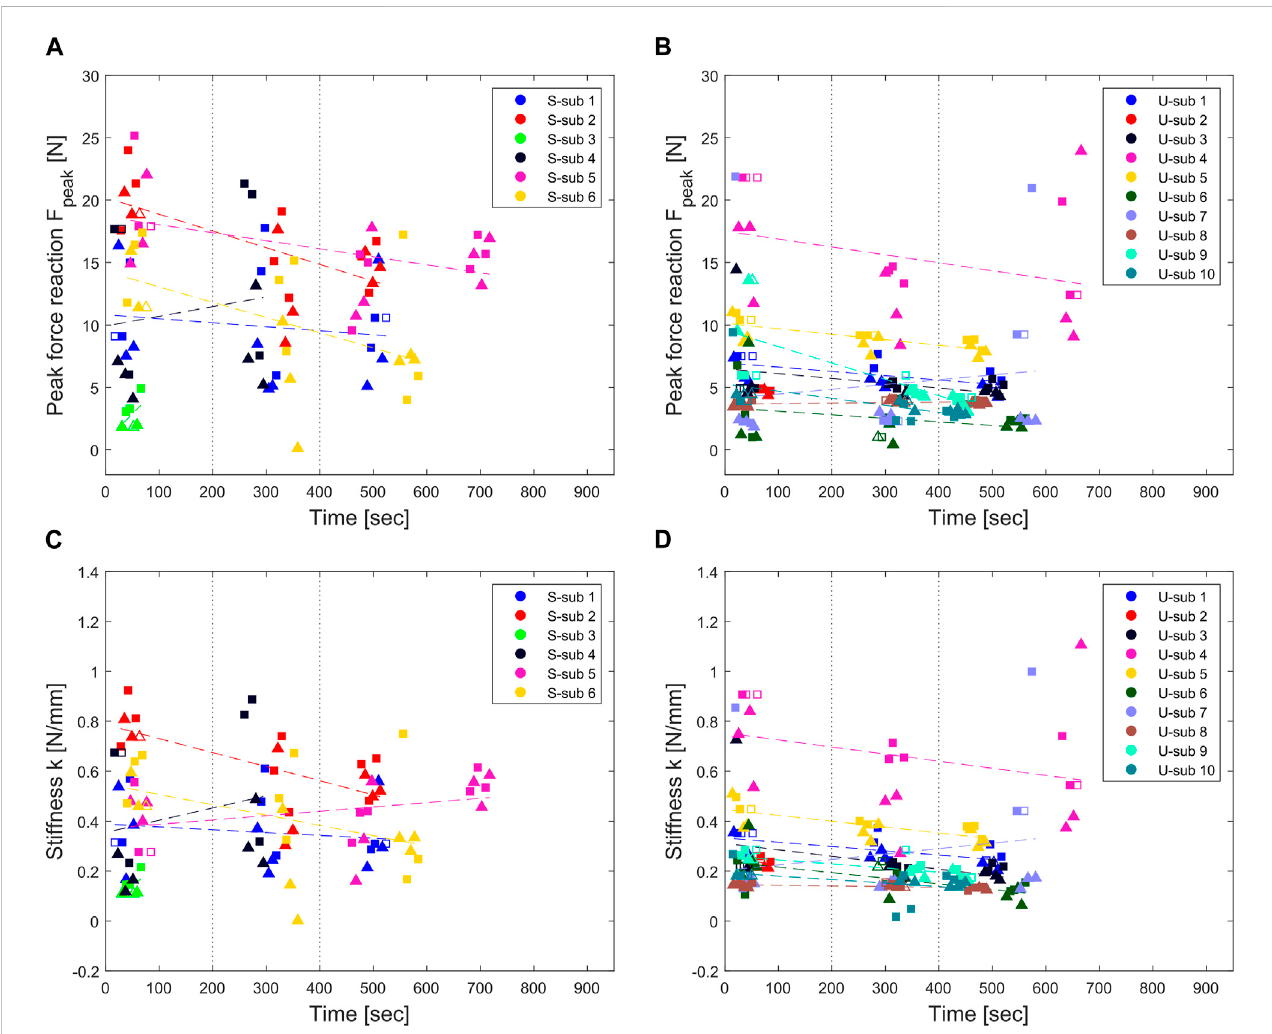
Peak force and stiffness results of individual perturbations over time in the stroke [ (A,C) , respectively] and unimpaired group [ (B,D) , respectively]. Triangular and squared markers represent slow and fast perturbations, respectively. The markers are empty when the perturbation was applied during a voluntary contraction and was thus replaced by theprevious or next perturbation [8.8 (4.5)% and 17.2 (7.6)% of theperturbations in the stroke and unimpaired group, respectively].Verticaldottedlines representthedivisionbetweentime clustersmatchingtheperturbation blocks.Colored dashedlinesrepresent the line fi t of the perturbation results over time for the individual